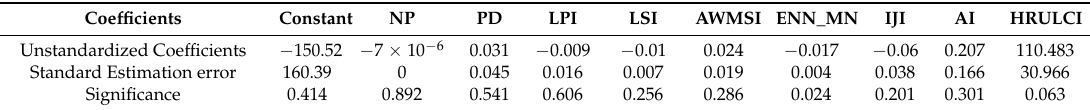
Table 9. The model significance table of COD Mn